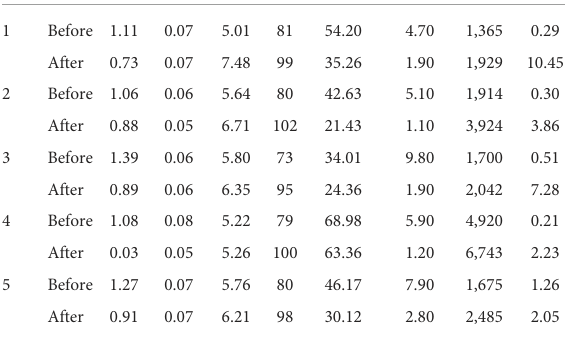
Real-time collection of 5 min ECG data using the algorithm presented in this article is used to identify R wave. The simulation results show that the algorithm recognition rate of R wave reaches 100%. To further verify the accuracy of the algorithm, 30min ECG data from the MIT/BIH ECG database is used to detect and identify R characteristic waves. Table 2 shows the statistics of the recognition rate of the R-wave recognition algorithm for partial ECG data randomly selected from the